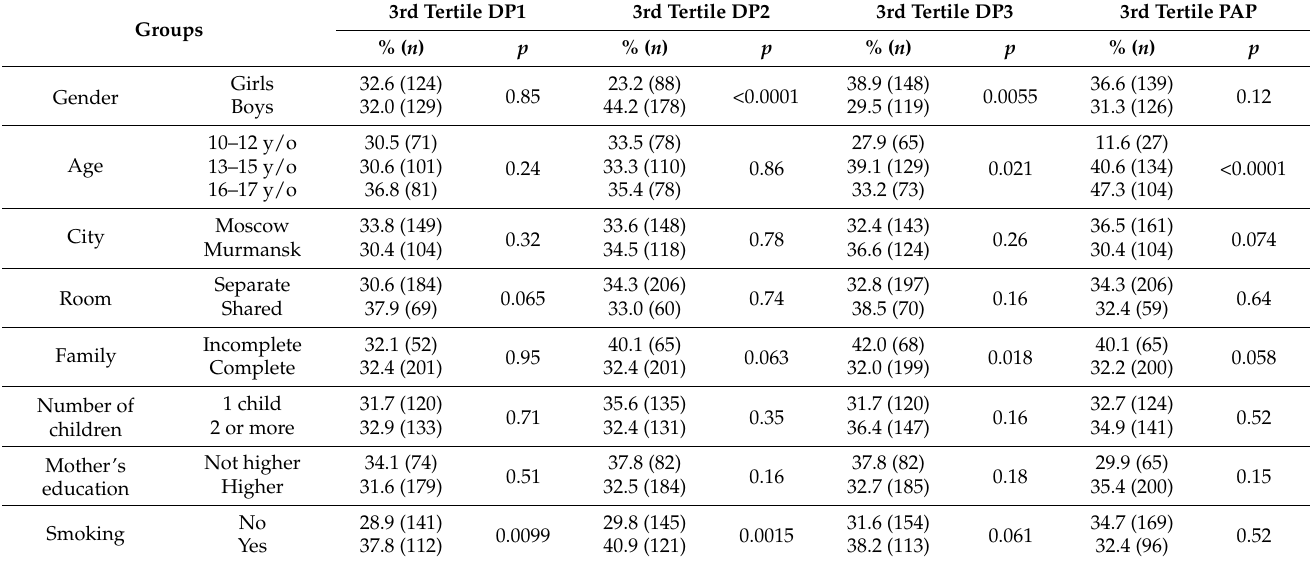
Table 3. Two-way associations of the proportion of children in adverse dietary and physical activity